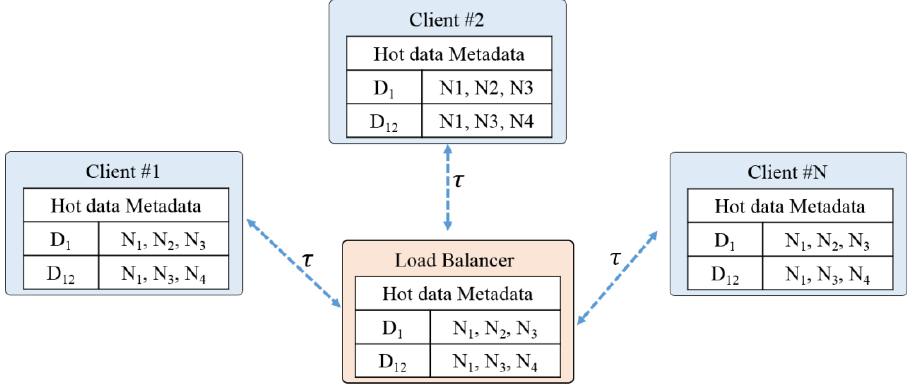
Figure 13. Update of the hot data metadata according to the communication cycle.